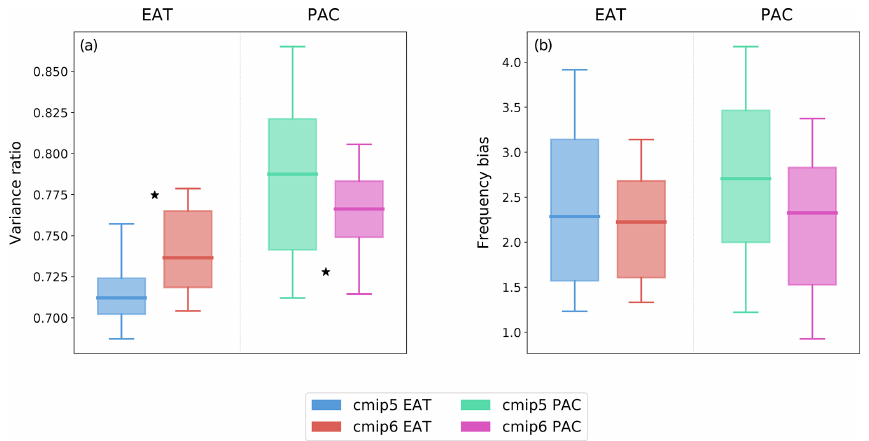
Figure 3. Variance ratio (a) and absolute frequency bias (b) for EAT and PAC regimes. CMIP5 models are indicated by blue (green for PAC) dots and CMIP6 by red (pink for PAC) boxes. The observed values of the variance ratio in the two sectors are indicated by the black